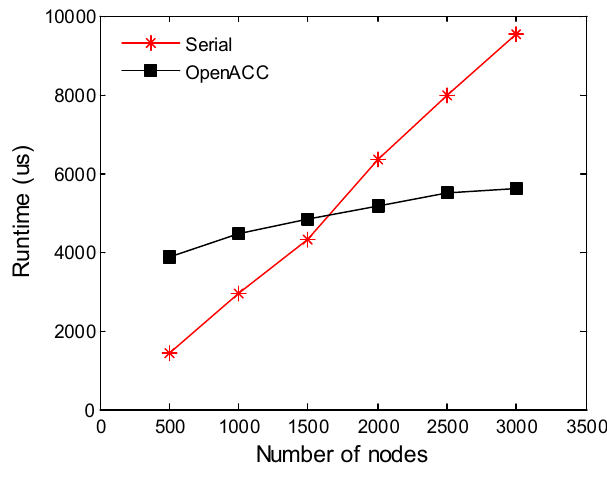
Figure 4. Jacobian matrix assembly.